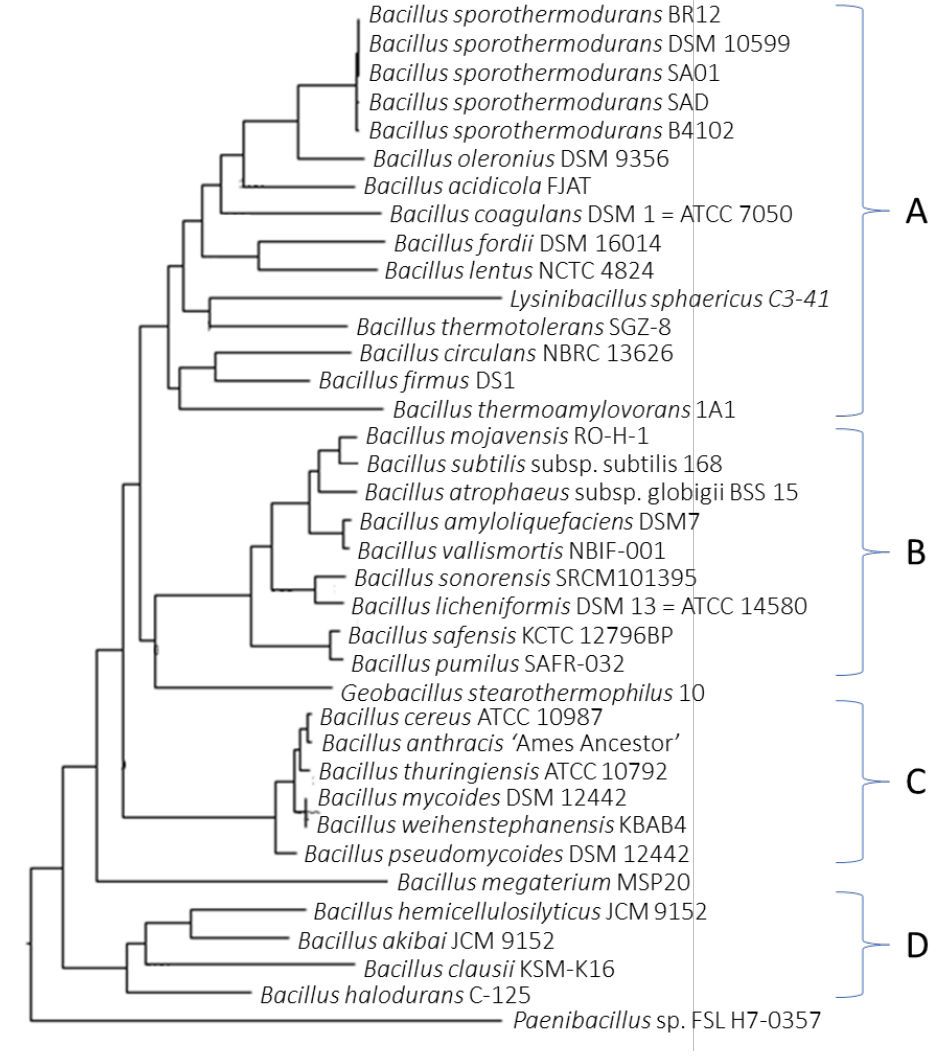
Figure 2. Phylogenetic analysis of Bacillus species showed distinct clusters for B. sporothermodurans and its group ( A ), B. subtilis group ( B ), B. cereus group ( C ), and selected alkaliphiles from Bacillus genus ( D ). The tree was constructed using the Randomized Axelerated Maximum Likelihood (RAxML) and FigTree programs.